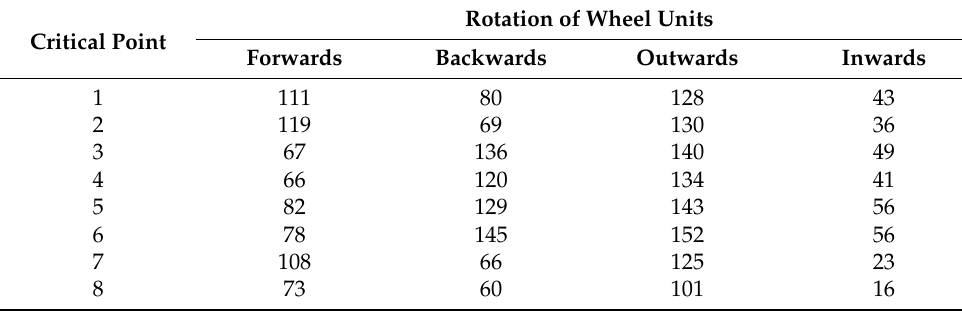
Table 3. Stresses at critical points of the crossbar (MPa).